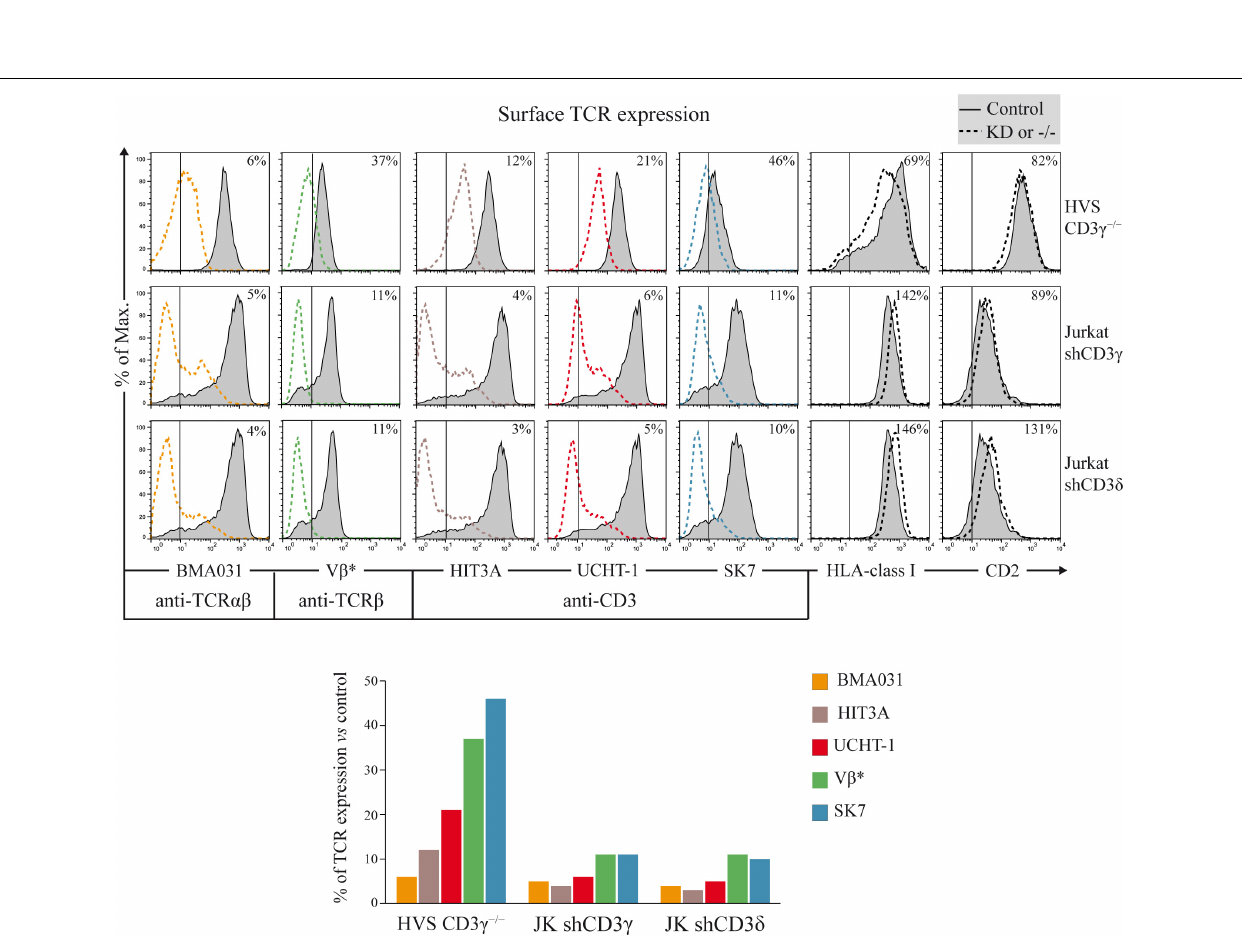
Frontiers in Cell and Developmental Biology |